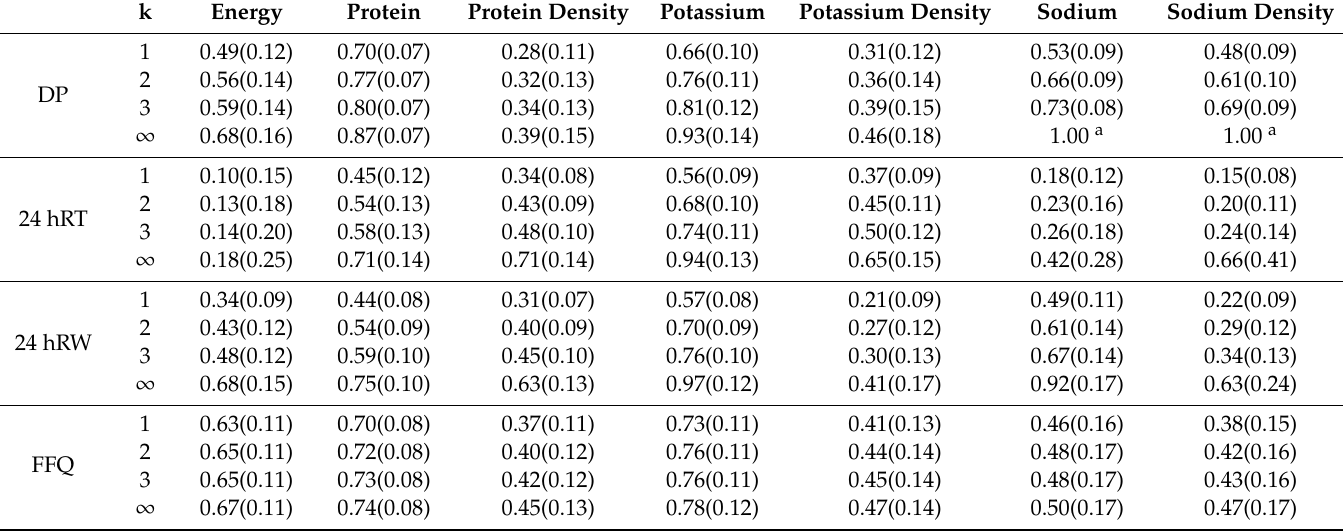
Table 2. Validity coe ffi cients (VC) of energy, protein, potassium, sodium and their nutrient densities for the DP, 24 hRT, 24 hRW and FFQ with the biomarker as the Reference method (mean